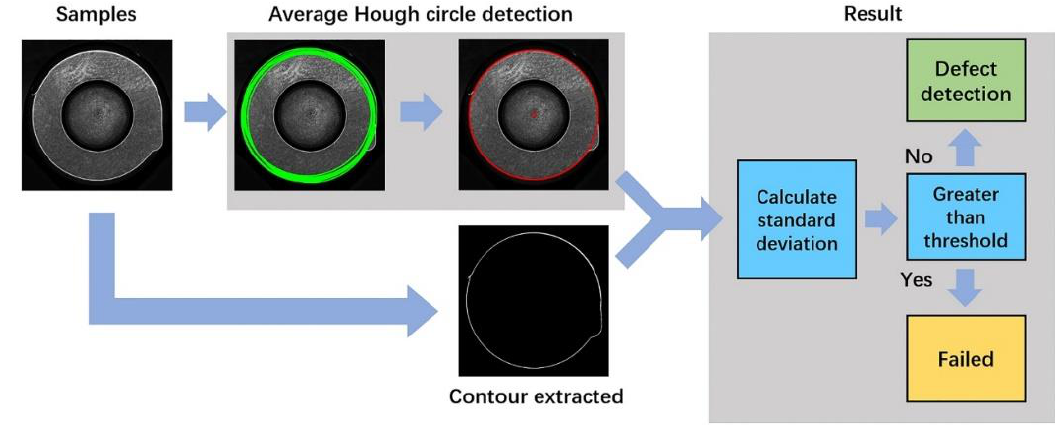
Figure 6. Contour detection process.